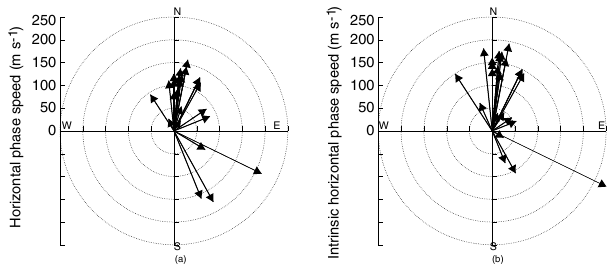
Figure 3. Vector diagrams for (a) observed and (b) intrinsic phase velocities. Each circle represents an isoline of 50ms − 1 .